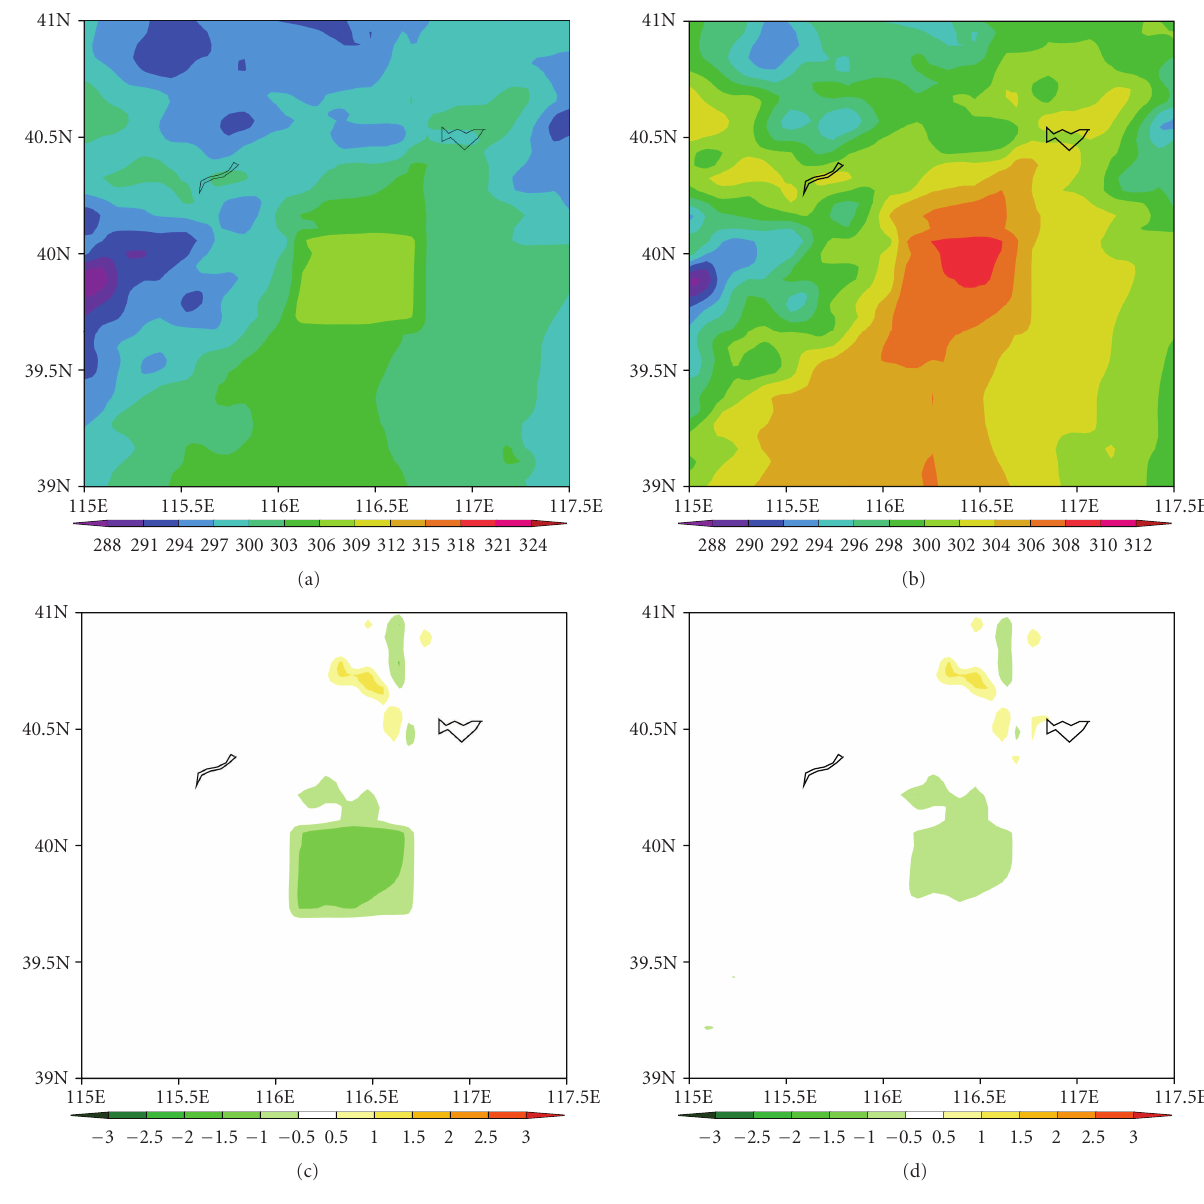
Figure 9: (a) the model output for the control run on skin temperature, (b) Model output for 2 m surface air temperature, (c) sensitivity run minus control run on skin temperature, and (d) sensitivity run minus control run on 2m surface air temperature. The outputs are on 12Z, July 27,